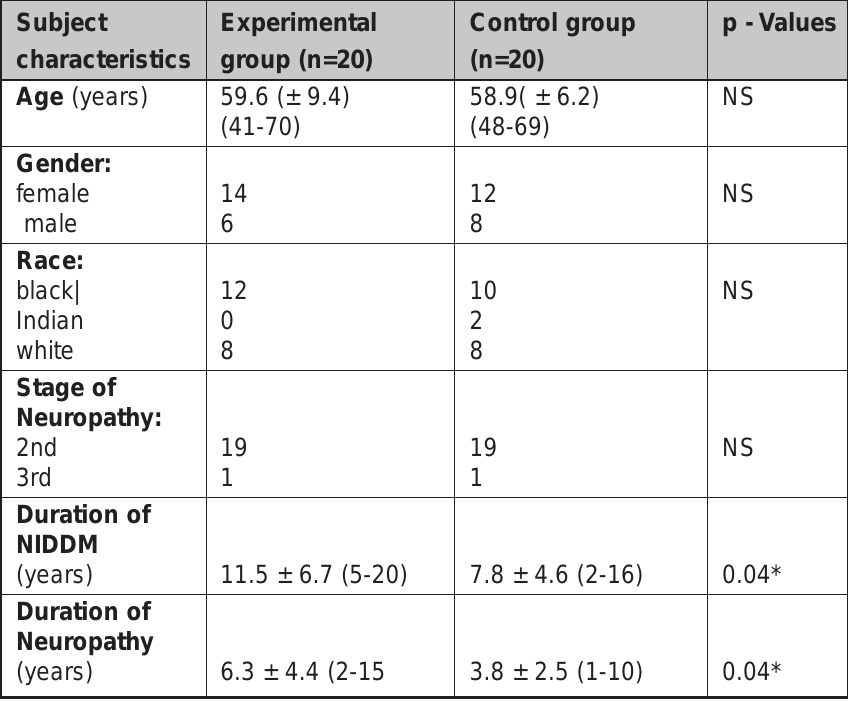
Table 1: Demographic characteristics of